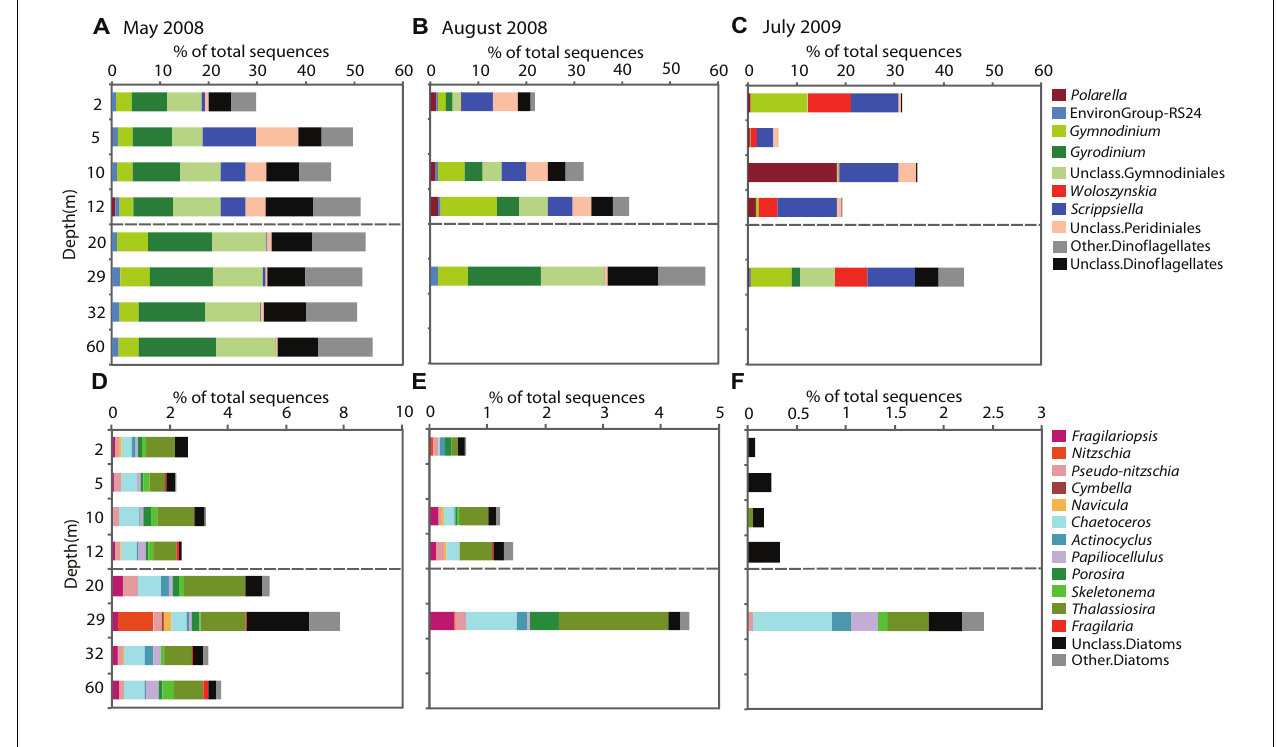
the dashed line and monimolimnion depths below.The proportions are based on total number of sequences (note differences in the x -axis scale for the different sampling times and groups).